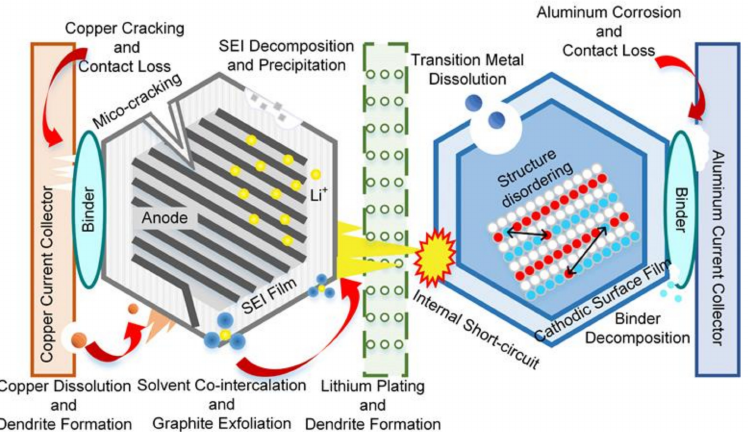
Figure 1. Lithium-ion battery various degradation mechanisms. Reproduced from [13] with the permission of Elsevier. Copyright